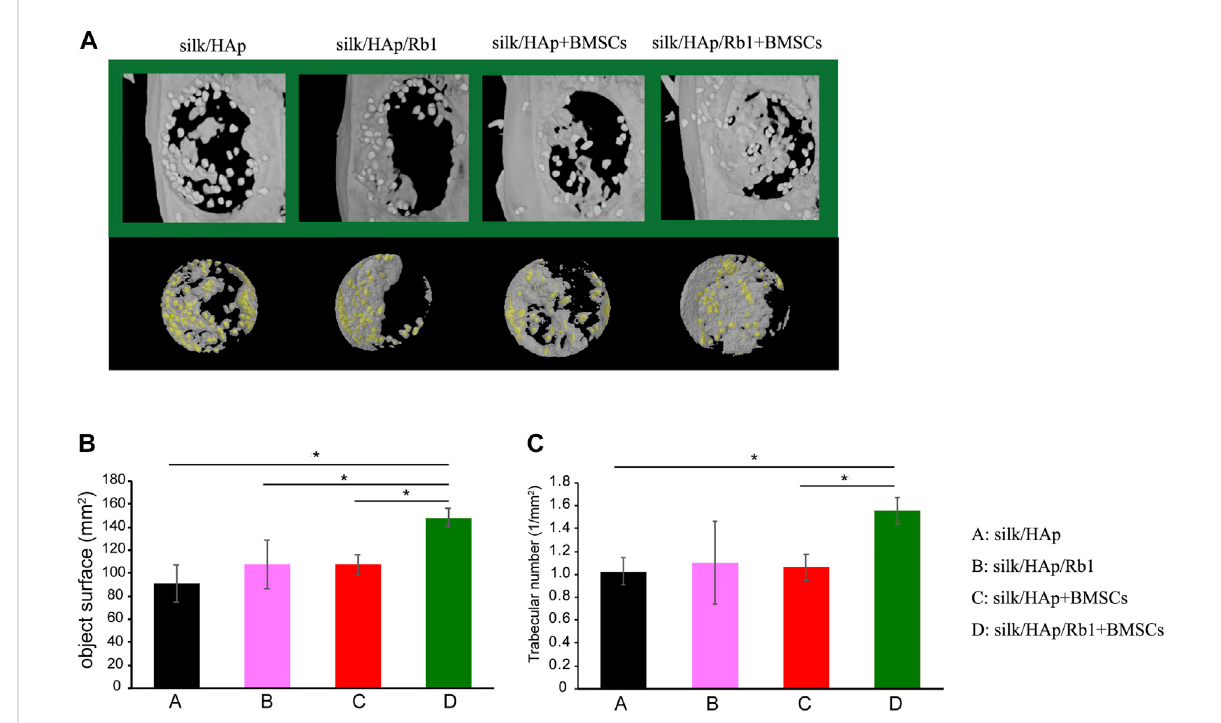
FIGURE 5 Micro-CT evaluation and morphometric analysis of calvarial defect repair. (A) Representative 3D super fi cial (B) object surface and (C) the trabecular number of calvarial defects were taken at 8 weeks after implantation, while the yellow color indicated the HAp granules (*, p <